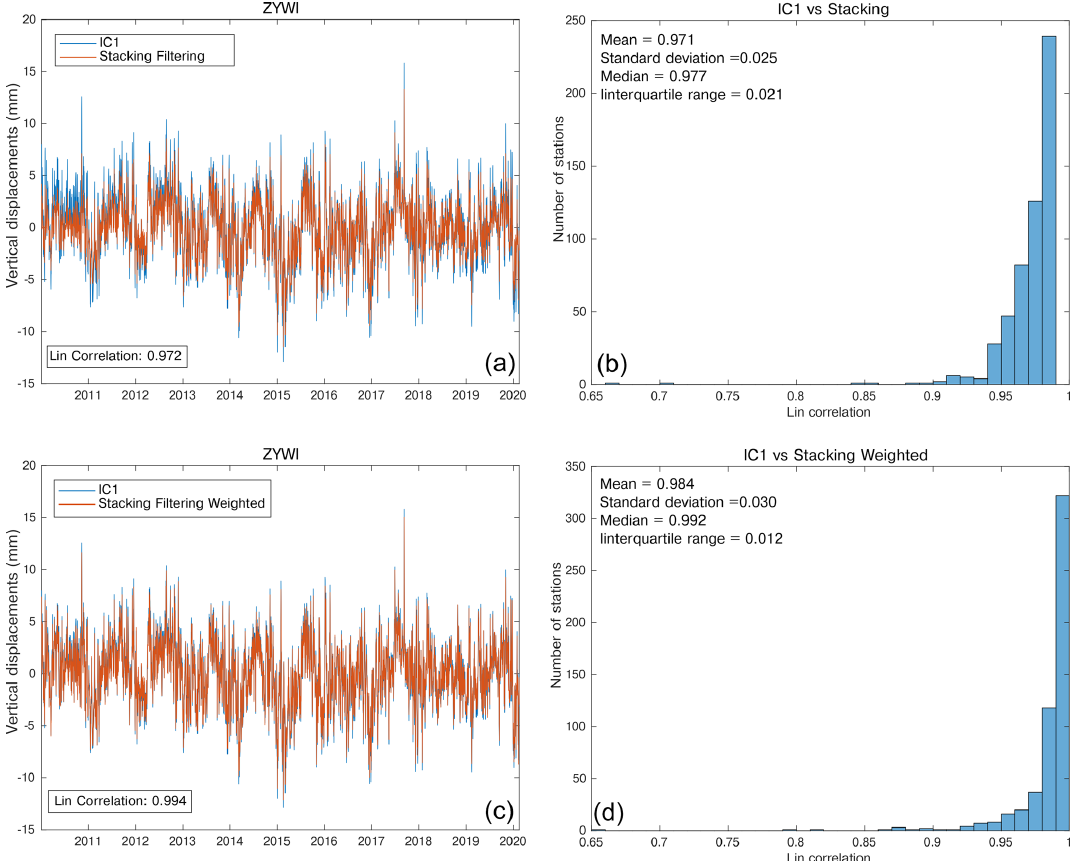
Figure 13. Comparison between the displacement associated with IC1 at the GNSS ZYWI site and the CME estimated with the stacking filtering method (a) and the weighted stacking filtering method (c) . We also show the histogram representing the Lin correlation between the displacements associated with the IC1 and the CME estimated with the stacking filtering method (b) and the weighted stacking filtering method (d) at each site. We point out that the CME computed with the aforementioned methods is, by definition, the same at each station, whereas the displacements associated with IC1 have the same temporal evolution but (slightly) different amplitudes. We plot the station ZYWI as an